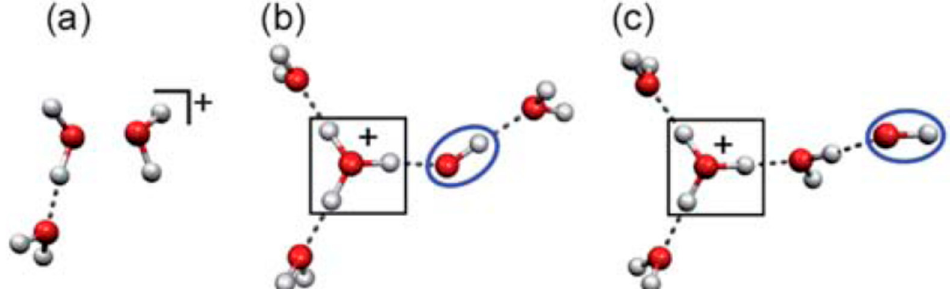
Figure 27. Three different structural motifs of (H 2 O) n+• (n ≥ 3). These structures were constructed from previous results [48,100,103]. The protonated site is indicated by a border. The •OH radical moiety is circled. ( a ) “Dimer cation core”-type structure. ( b ) Structure with the H 3 O + ion in contact with the • OH